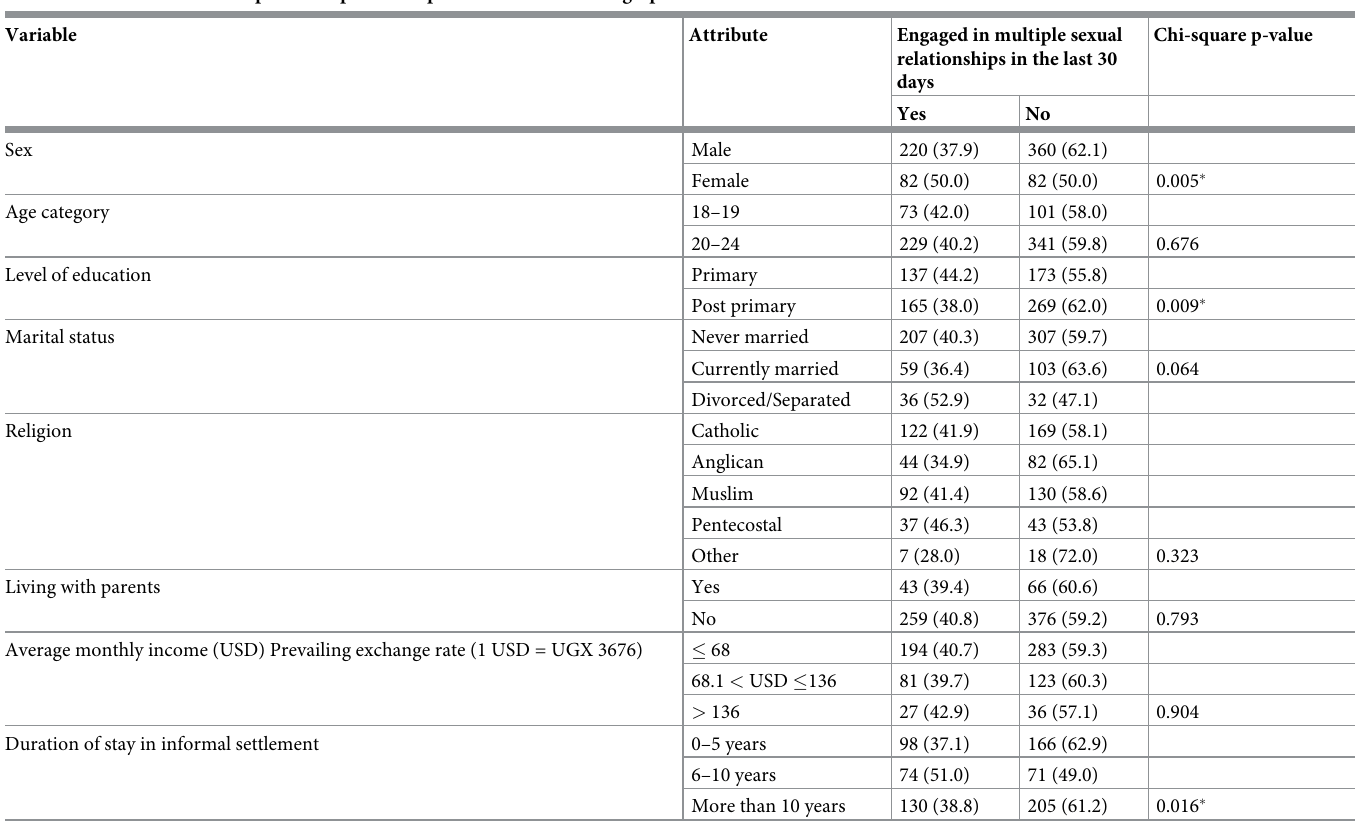
Table 2. Distribution of multiple sexual partnerships based on socio-demographic